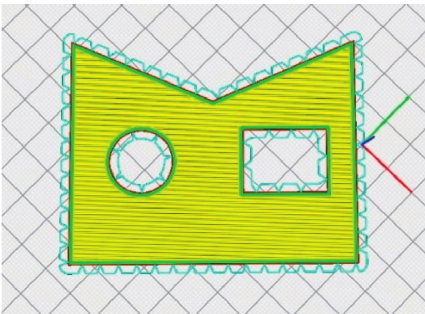
Figure 10: Model of the novel platform attached support structure